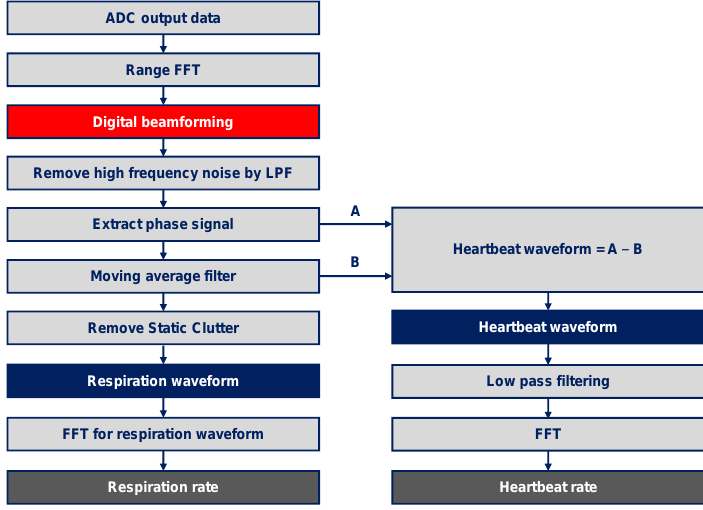
Figure 3. The flow chart of signal-processing algorithm monitoring respiration and heartbeat rates.